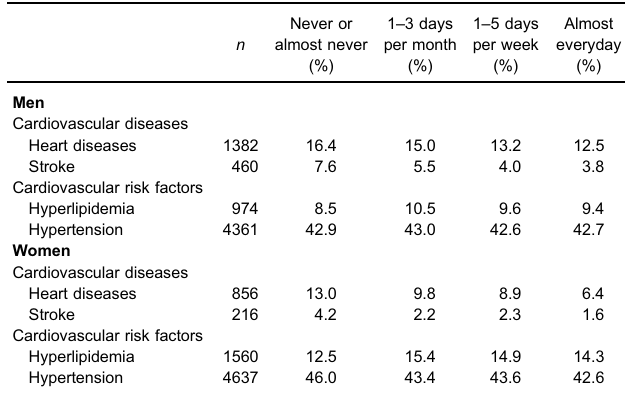
Table 2. Frequency of laughing in 4 weeks by participants ’ status of cardiovascular diseases and risk factor